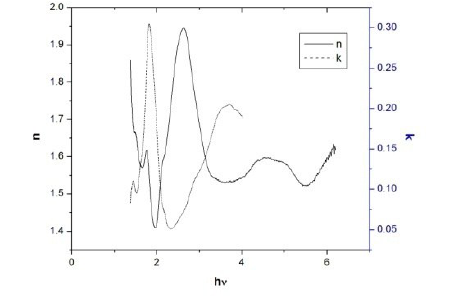
Figure 5 . Plot of refractive index n and extinction coefficient k versus photon energy for as-deposited Cl Film.